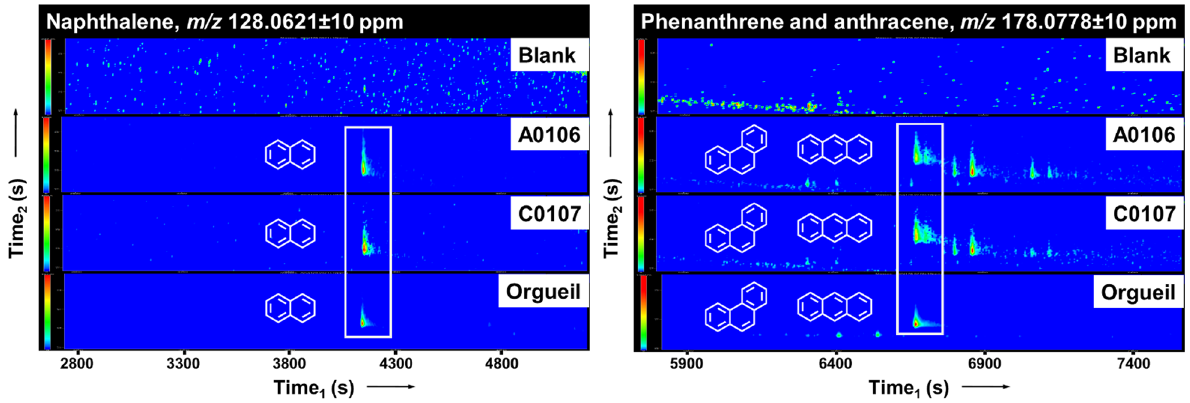
Fig. 3 GC GC–HRMS analysis of naphthalene characterized by m/z 128.0621 10 ppm, and phenanthrene and anthracene characterized by m/z × ± 178.0778 10 ppm from the baked serpentine blank, Ryugu samples A0106, C0107, and the Orgueil meteorite DCM extracts. The insert color scales ± represent relative peak intensities, where colder colors (blue toward green) indicate lower values and warmer colors (yellow to red) higher values. The timeframe for the second dimension (Time 2 ) in each chromatogram of naphthalene goes from 0.5 to 3.5 s (Start: 0%; Stop: 100%, Factor: 2), and for phenanthrene and anthracene from 1.1 to 3.6 s (Start: 2%; Stop: 80%, Factor: 1.5). The regions of interest in the chromatograms are indicated by the white rectangles. Signals outside these regions are other species which could not be definitively identified via a comparison of retention time